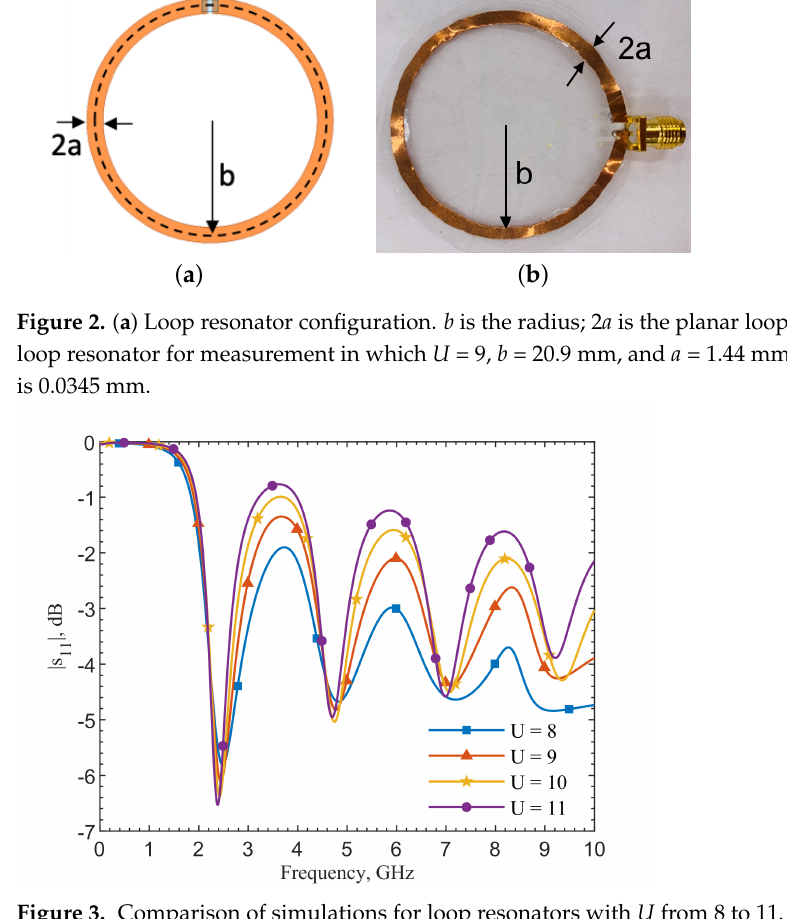
Figure 3. Comparison of simulations for loop resonators with U from 8 to 11.